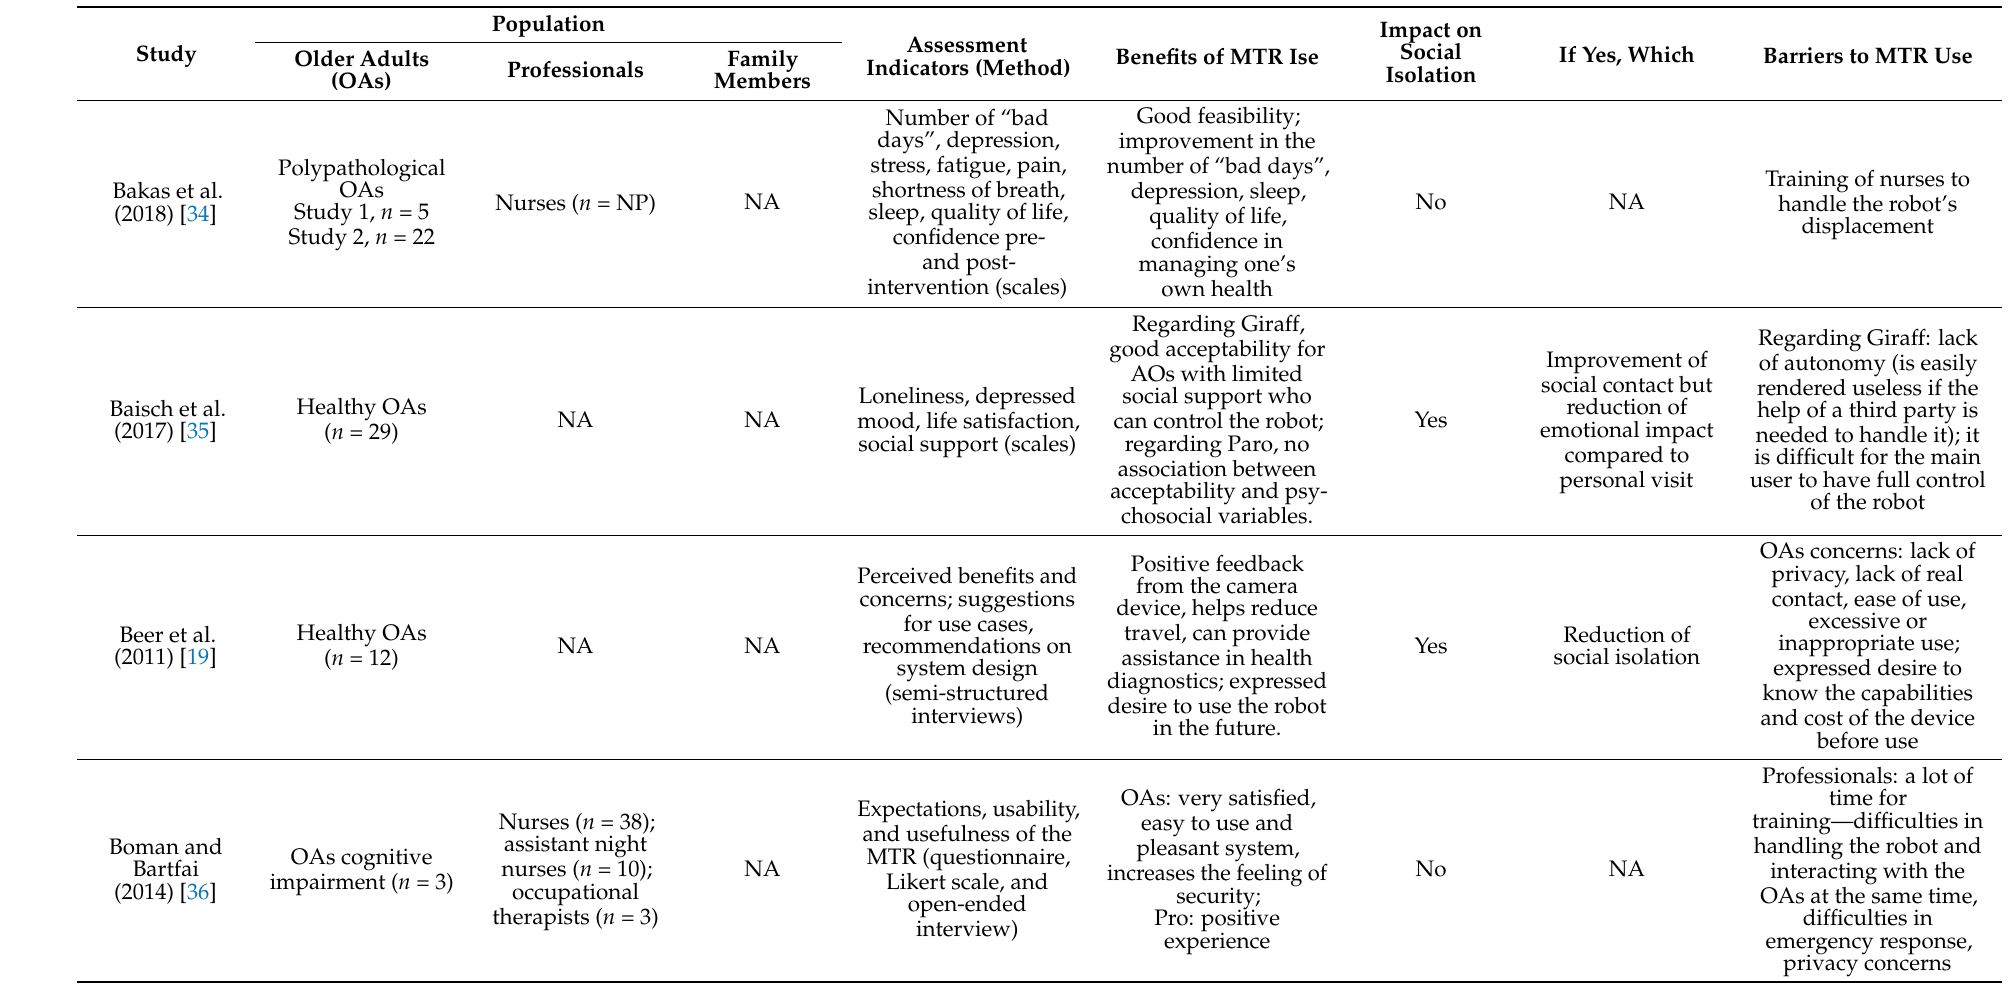
Table 3. Selected pertinent articles to the subject